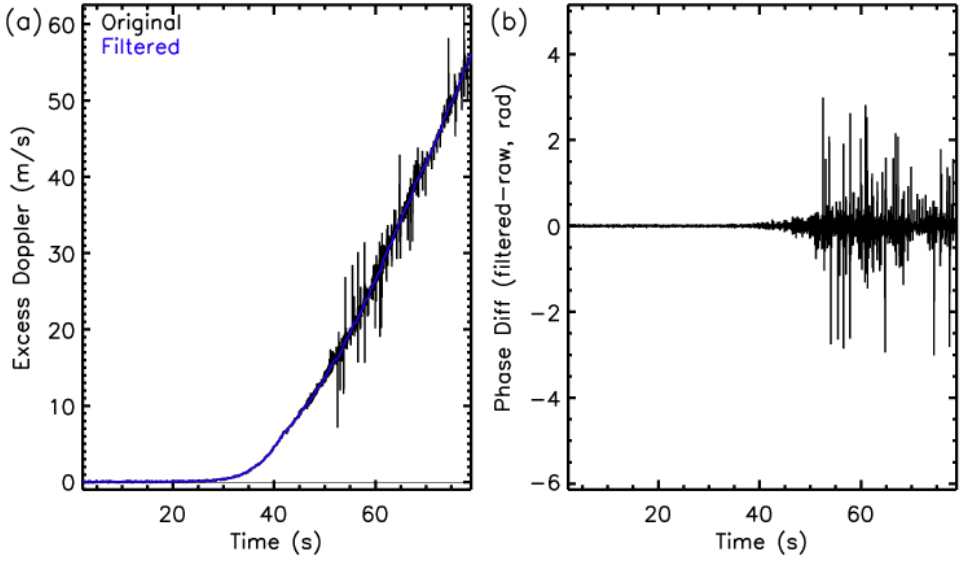
Figure 6. ( a , b ) Excess Doppler for the RO sounding on 1 October Figure 6. Excess Doppler for the RO sounding on October 01, 2019.